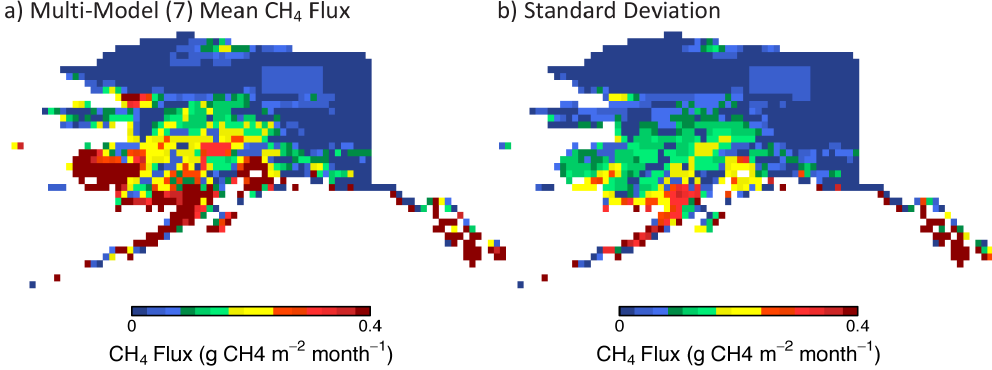
flux for Alaska. Model output was part of the 950 4